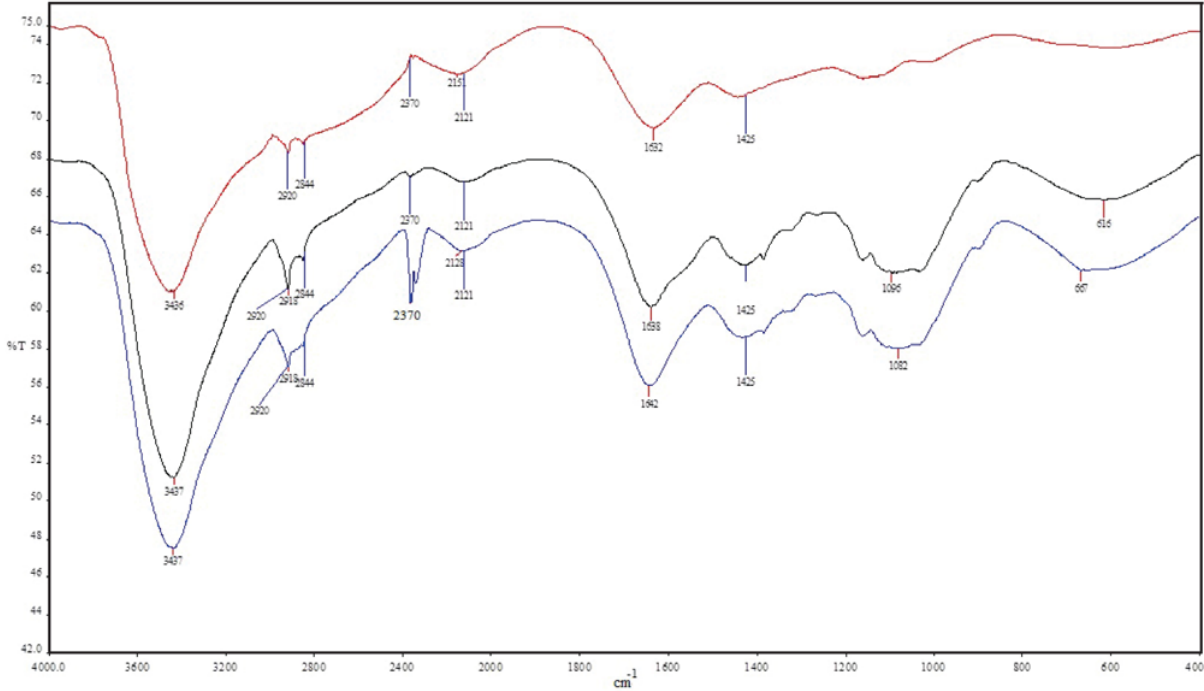
Figure 1. FTIR spectrum of native chitosan film (red) and corn cob film before adsorption (black) and after adsorption (blue)